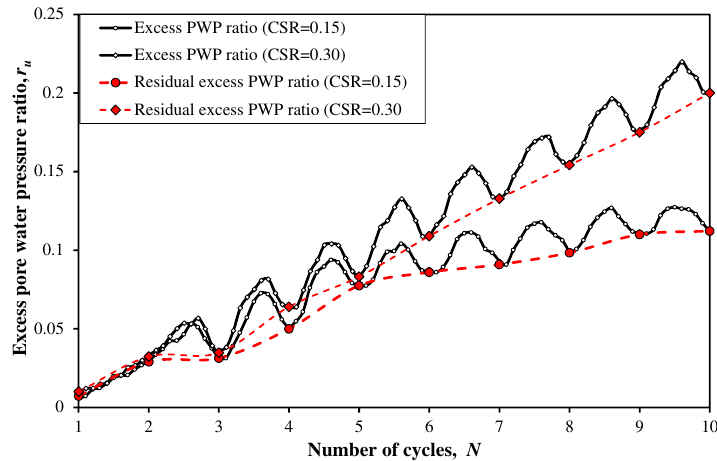
Fig. 4 Development of residual excess pore water pressure ratio of Ta_CYC0.15(84),